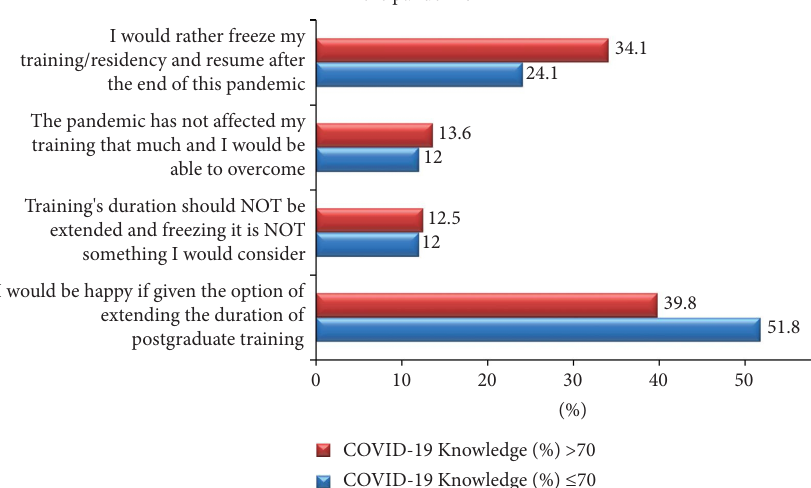
Figure 5: Association of the level of COVID-19-related knowledge with the thoughts of the residents on status of their postgraduate training during the